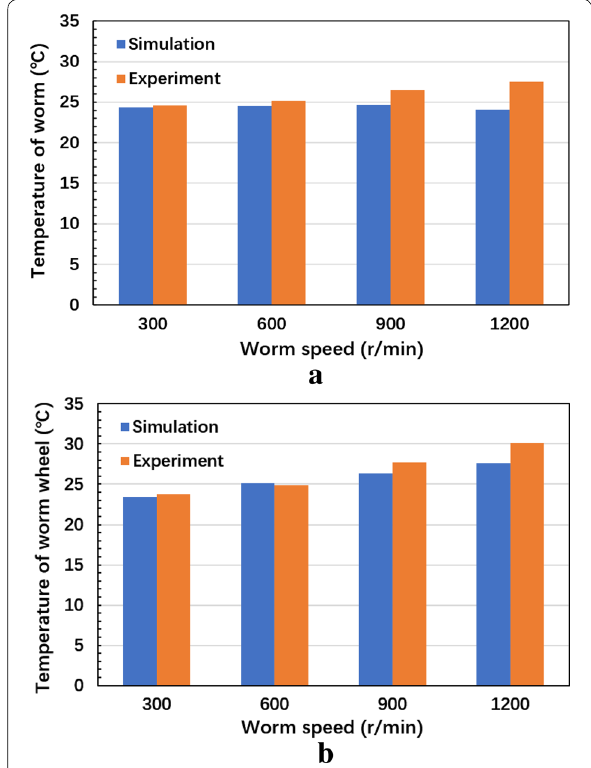
Figure 13 a Temperature variation of worm at different rotating speeds, b temperature variation of worm wheel at different rotating speeds